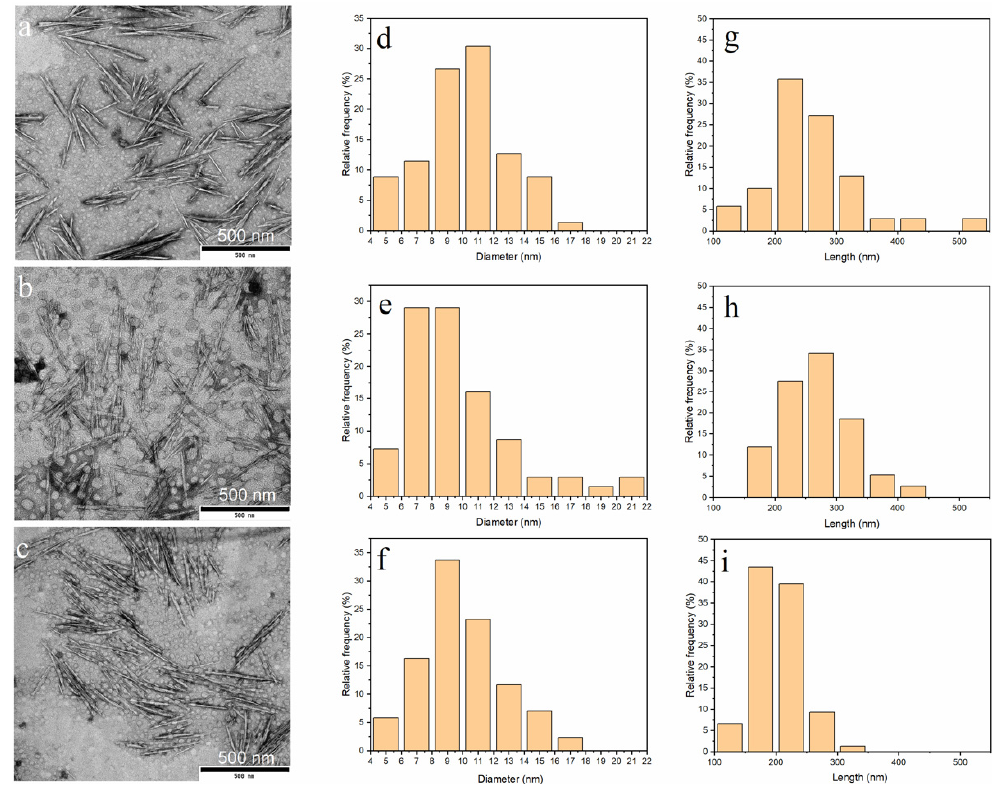
Figure 3. Transmission electron microscope (TEM) images and diameter and length distributions of ChNCs: ( a , d , g ) DES 70-3 , ( b , e , h ) DES 100-1 , and ( c , f , i ) DES 100-3 . Table 2. Dimensions of ChNCs prepared with DES under different reaction conditions. Samples Length